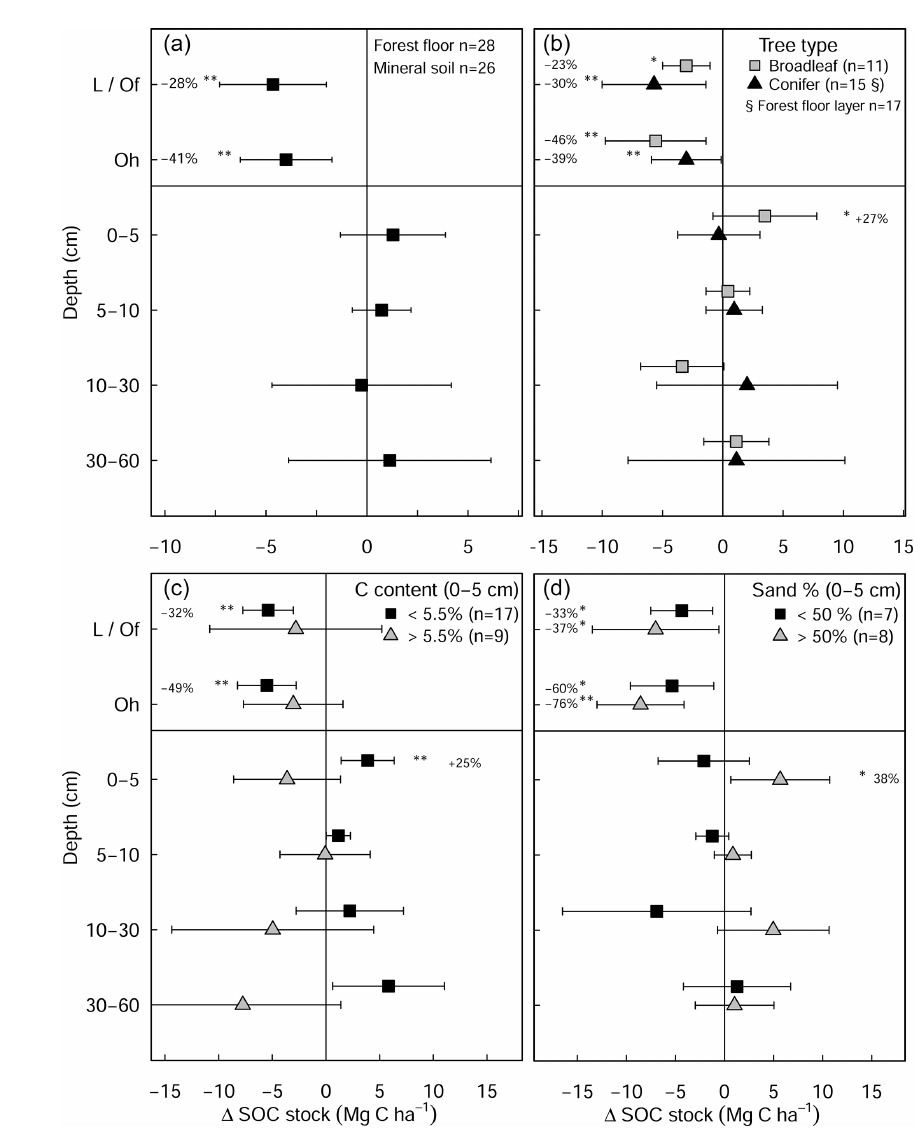
Figure 3. Changes in mean soil organic carbon stock (limed − control) as a result of liming (a) for all plots in the experiment and classified by (b) tree types and (c) inherent C content of the control plots and (d) site sand percent from 0–5cm depth. Error bars indicate the 95% confidence intervals based on Student’s T distribution. Statistical significance was tested using LME models for each respective soil depth/layer and grouping at P ≤ 0 . 05 (*) and P ≤ 0 . 01